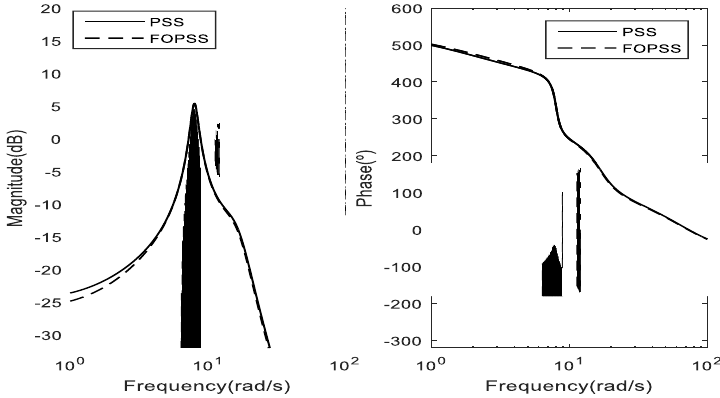
Figure 11. Bode Plot of L 0FOPSS (s) and L 0PSS (s) .